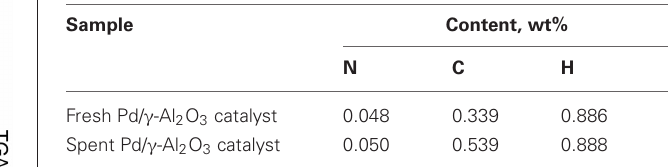
Table 1 | Elemental analysis of fresh and spent